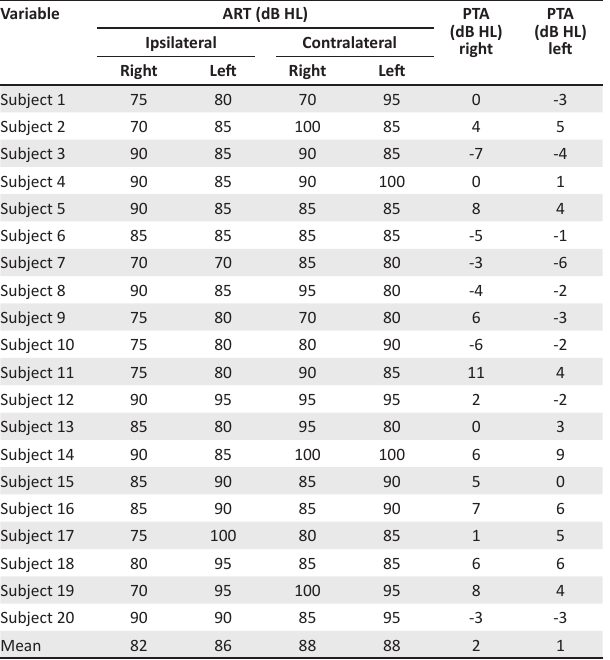
TABLE 2: Results of acoustic reflex threshold and pure tone audiometry from normal ears ( n = 40).